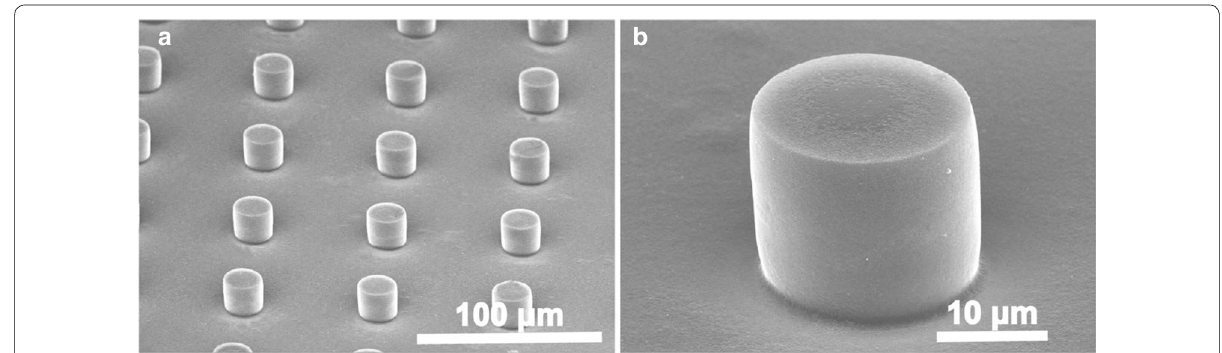
Fig. 1 Field emission scanning electron microscope (FESEM) images of the siloxane functionalized μ‑patterned GO incorporated PUA hybrid superhydrophobic film at ( a ) lower and ( b ) higher magnifications